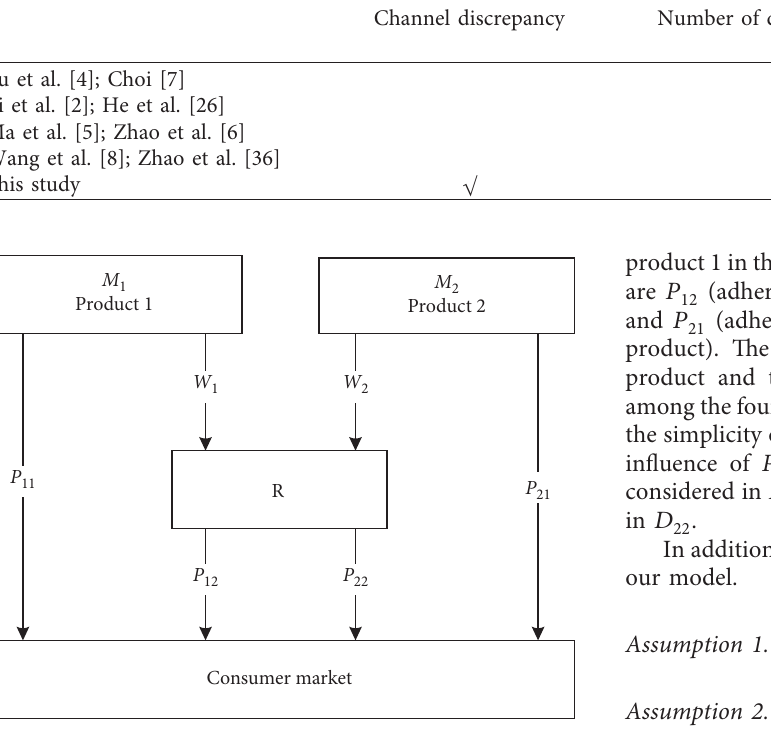
Figure 1: Dual-channel supply chain